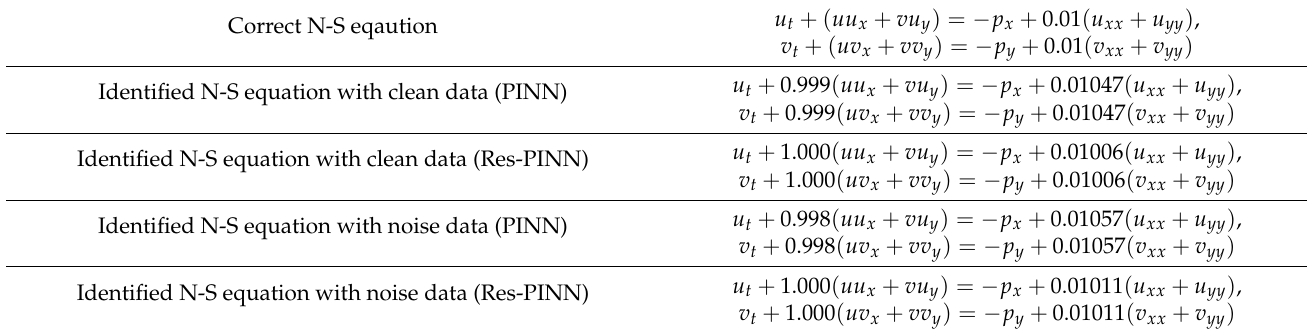
Table 3. The Correct NS equation versus with the identified NS